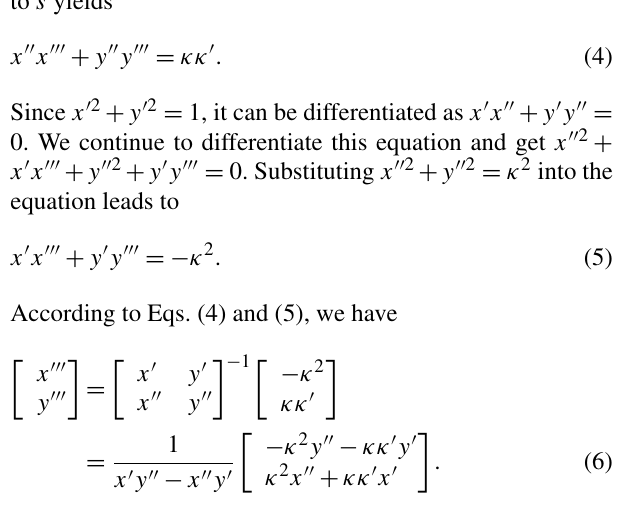
Figure 4. Large deflection of a flexural beam subject to arbitrary end loads.